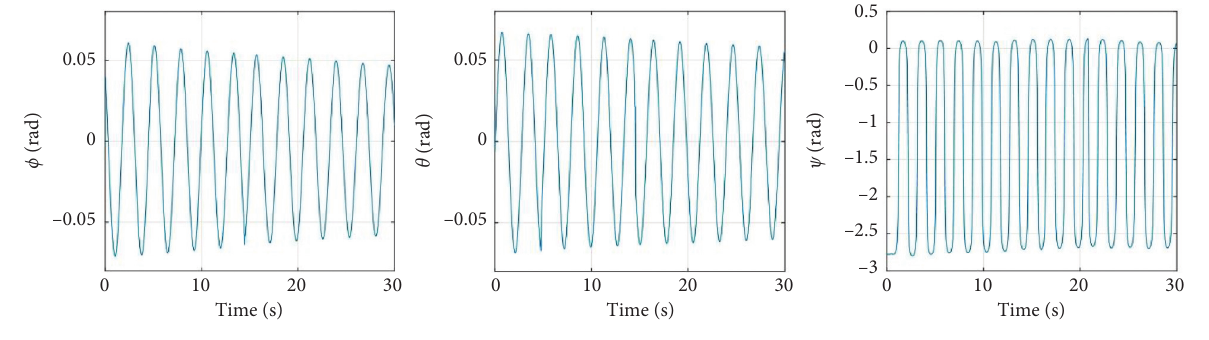
Figure 3: Test results.